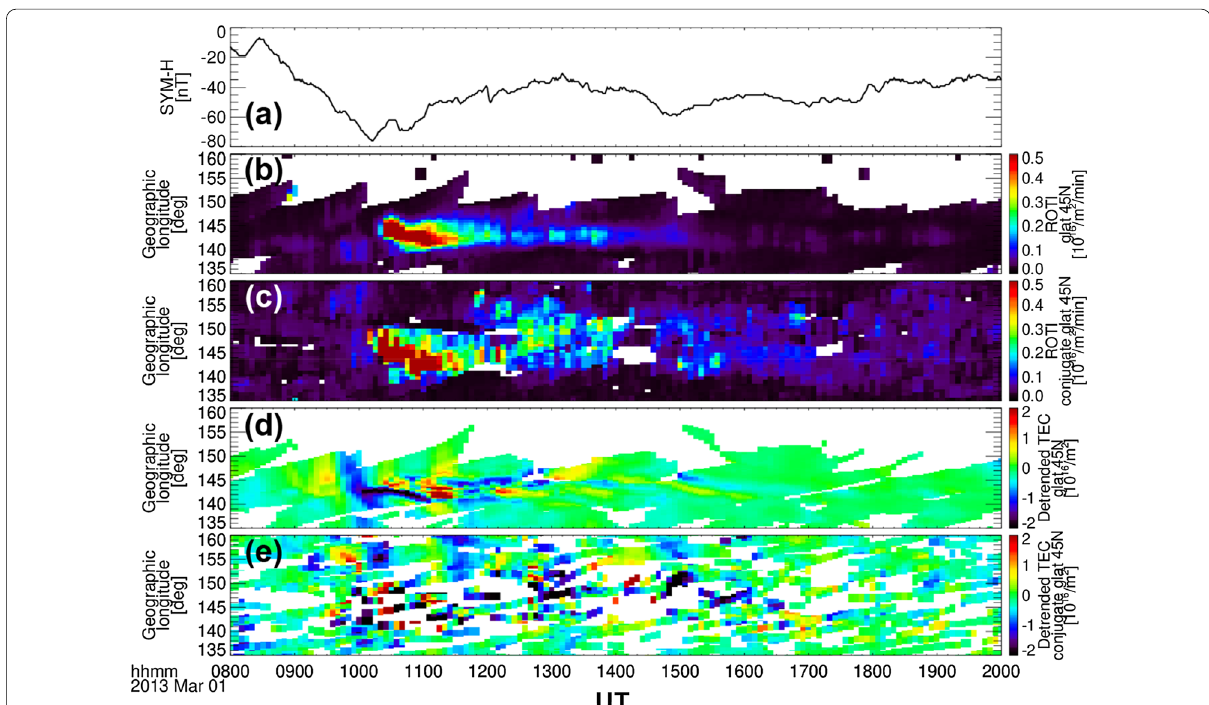
Fig. 7 Time-series plot of a SYM-H index, and geographic longitude–time plots of ROTI, b from 135° to 160° E at 45° N and c over geomagnetically conjugate points in the southern hemisphere for the location of 135°–160° E at 45° N on March 1, 2013. Panels d and e are the same as Panels b and c , respectively, for the detrended TEC. The color codes in Panels b and c indicate the ROTI value within a range of 0.0 to 0.5 TECU/min. The color codes in Panels d and e show the detrended TEC values within a range of -2 to 2 TECU. Universal time plus 9 h corresponds to the local time in the Asian sector (LT UT 9 = +